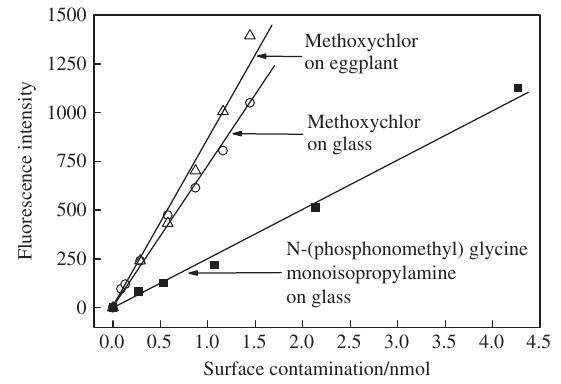
Calibration plots for the two pesticides on glass and on eggplant surfaces ( Hassoon and Schechter 2000 ).